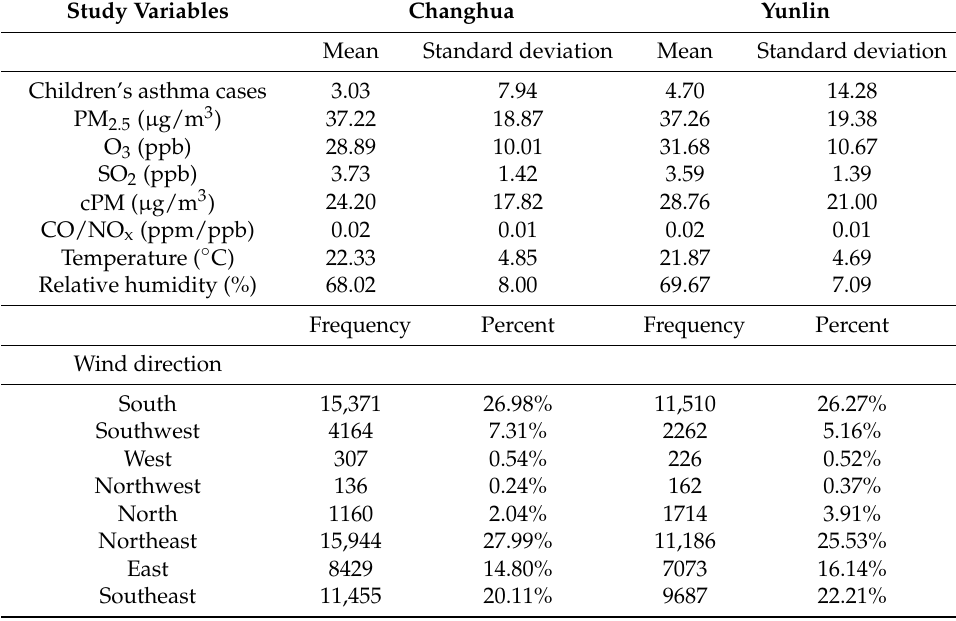
Table 1. Characteristics of study